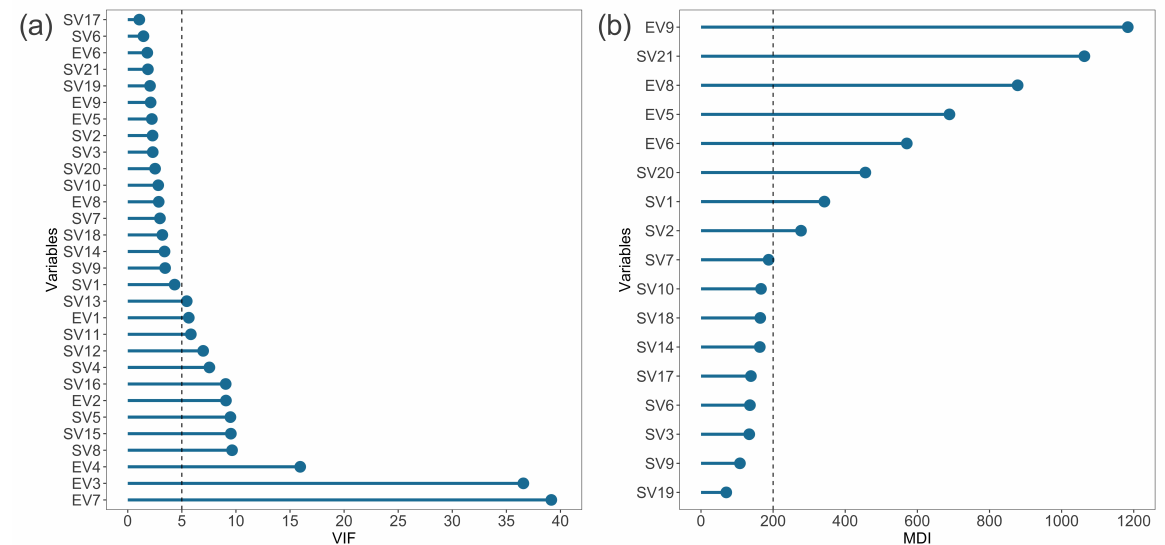
Figure 2. Two-step variables screening procedure: ( a ) remove variables with higher multicollinearity (VIF > 5); ( b ) select variables with the higher relative importance (MDI >